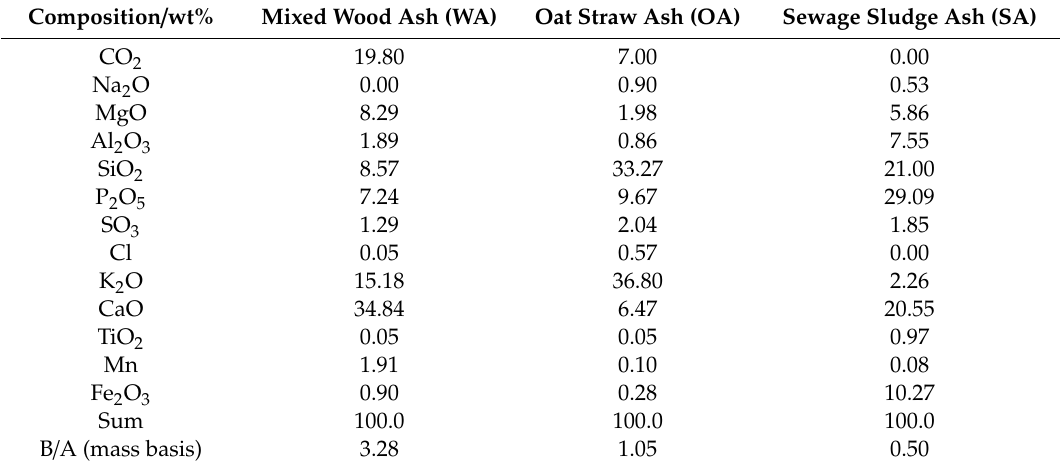
Table 2. Chemical composition of the investigated ashes determined after ashing in line with DIN EN ISO 18122 and DIN